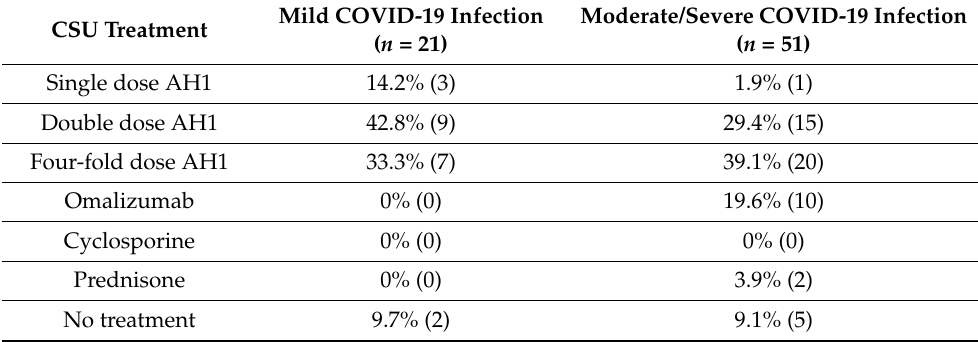
Table 2. CSU treatment during COVID-19 mild or moderate-severe type of disease, represented as percent and number of patients.